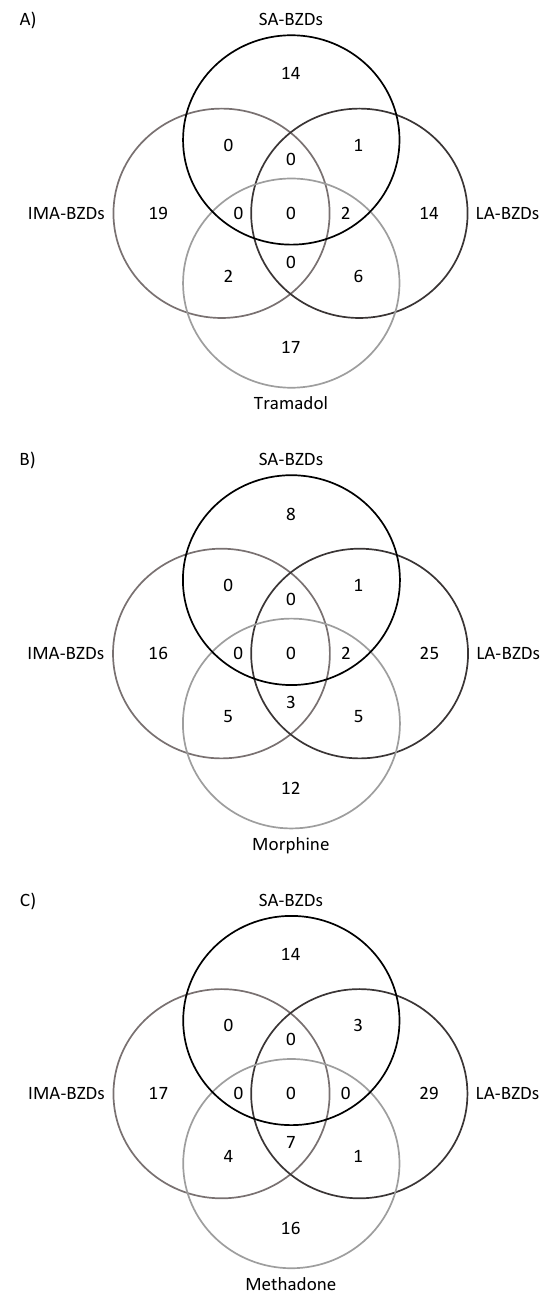
Figure 1. Shows the numbers of deceased testing positive for the most frequently found combinations of opiates. The number in the intersections shows the number of deceased positive for more than one class of substance. ( A ): Shows the numbers of deceased positive for tramadol and short-acting benzodiazepines (SA-BZDs), long-acting benzodiazepines (LA-BZDs), and intermediate-acting benzodiazepines (IMA ‐ BZDs). ( B ): Shows the numbers of deceased positive for mor ‐ phine and LA ‐ BZDs, IMA ‐ BZDs, and SA ‐ BZDs. ( C ): Shows the numbers of deceased positive for methadone and LA ‐ BZDs, IMA ‐ BZDs, and SA ‐ BZDs.